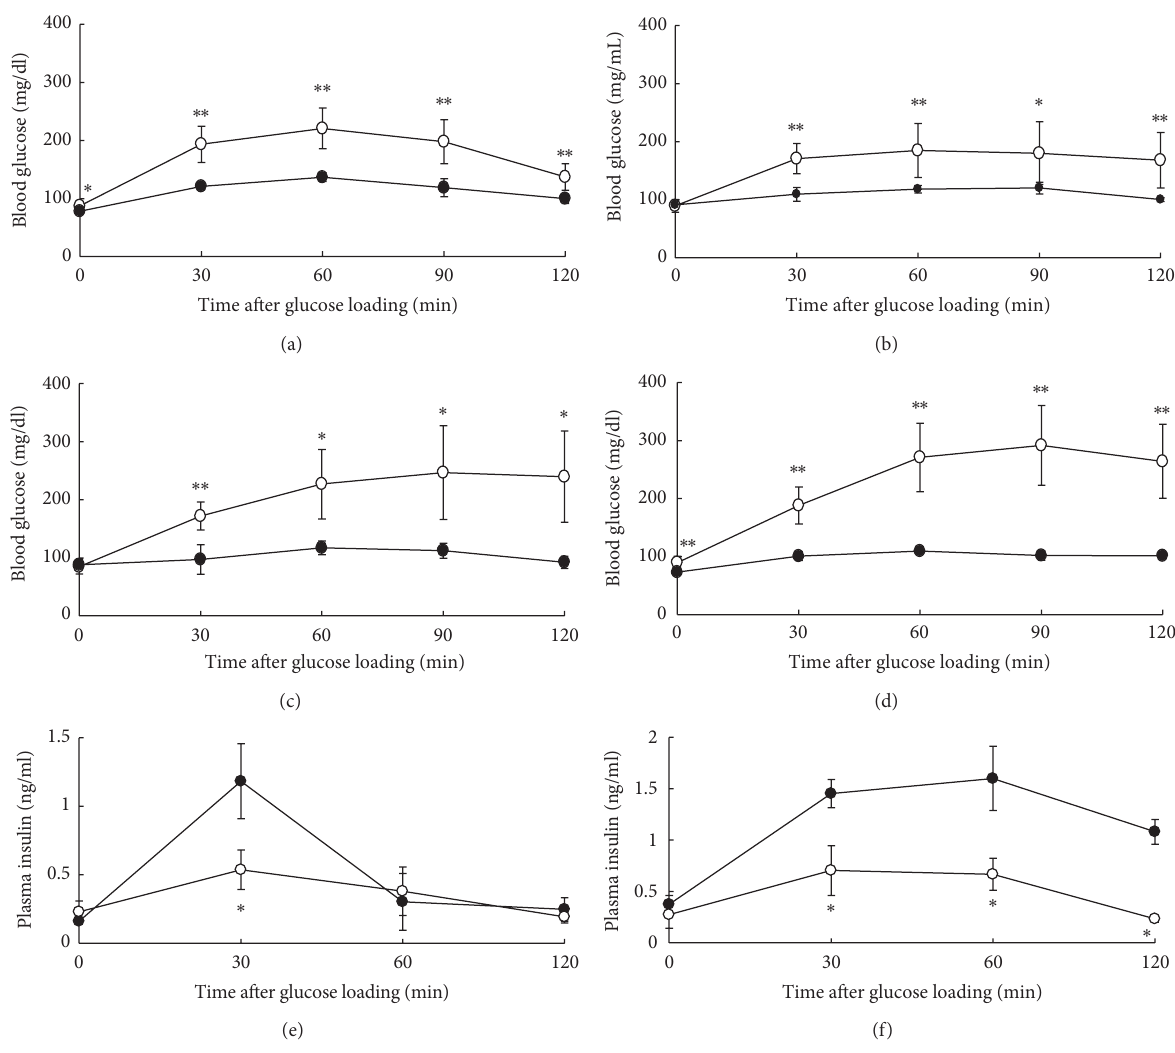
Figure 2: Blood glucose levels after glucose loading in male LEA ( 𝑛 = 11 , open circle) and Wistar rats ( 𝑛 = 5 , closed circle) at 2 months of age (a), in male LEA ( 𝑛 = 12 , open circle) and male Wistar rats ( 𝑛 = 4 , closed circle) at 6 months of age (b), in male LEA ( 𝑛 = 13 , open circle) and Wistar rats ( 𝑛 = 3 , closed circle) at 12 months of age (c), in male LEA ( 𝑛 = 15 , open circle) and Wistar rats ( 𝑛 = 3 , closed circle) at 14 months of age (d). Plasma insulin levels after glucose loading in male LEA ( 𝑛 = 3 , open circle) and Wistar rats ( 𝑛 = 4 , closed circle) at 2 months of age (e), in male LEA ( 𝑛 = 5 , open circle) and Wistar rats ( 𝑛 = 3 , closed circle) at 12 months of age (f). Each value is expressed as the mean ± SD. ∗ 𝑃 < 0.05 . ∗∗ 𝑃 < 0.01